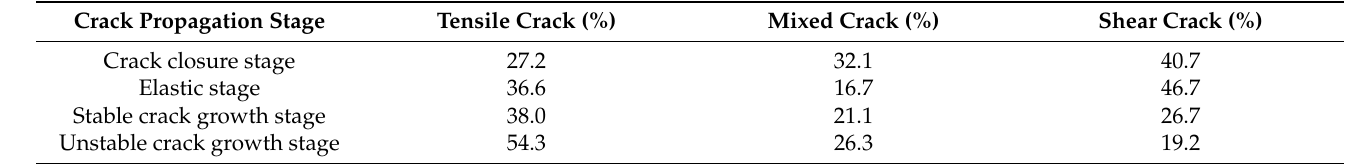
Table 4. Different crack types in the process of rock failure of sample S-T1-0.